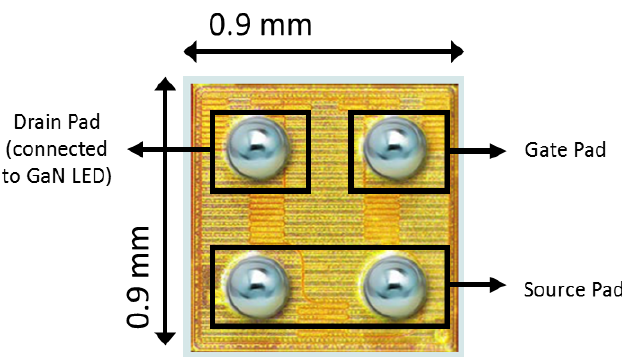
Figure 6. EPC2036 in passivated die form with solder bumps.